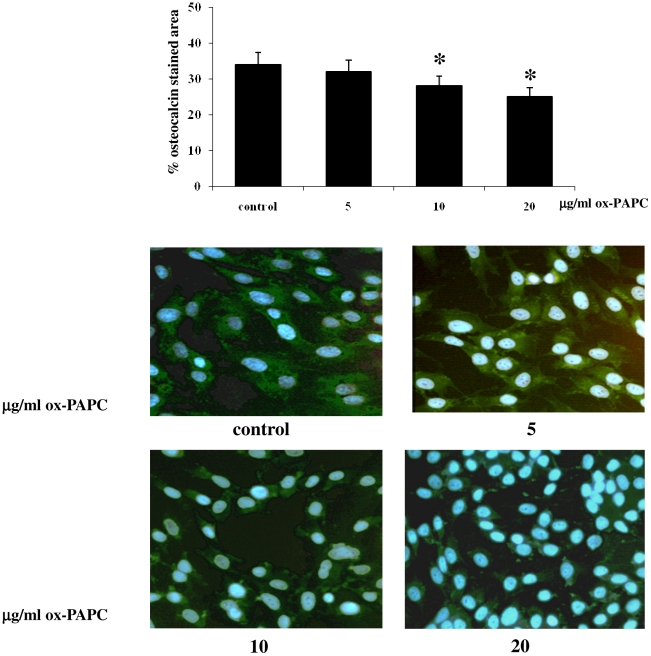
Osteocalcin immunofluorescence.After 10 days of ox-PAPC treatment during osteogenic differentiation, osteocalcin expression decreased in hMSCs in a dose dependent manner (n = 3; p<0.05). (original magnification 20×).